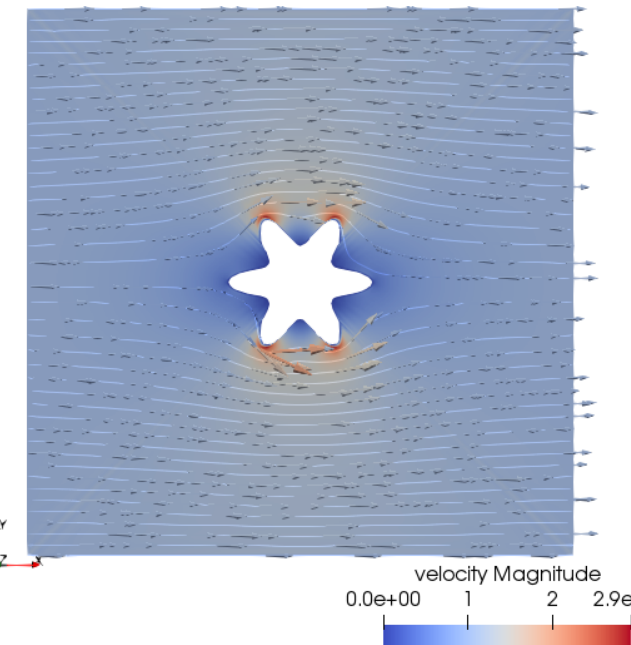
Figure 22. Case 4: the velocity representation with stream lines.